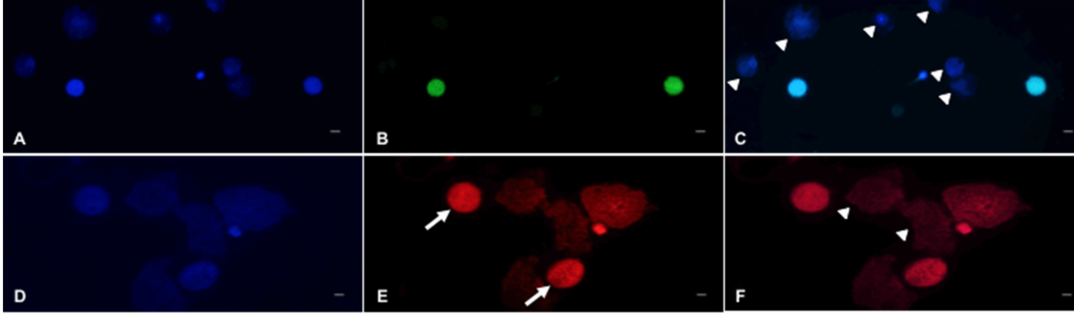
Figure 6. Representative cells with fragmented DNA or non-viable cells in testicular tissue from black-footed ferrets. ( A , D ) Nucleus stained with Hoechst, ( B ) live cells with fragmented DNA showing bright green nucleus, ( C ) merged image (white arrow heads indicate live cells with intact DNA), ( E ) dead cells showing bright red nucleus (arrows), ( F ) germ cells merged image (white arrow heads indicate live cells). Bar = 5 µ